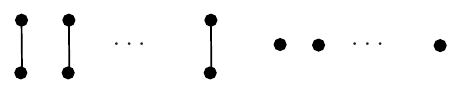
Figure 5: The maximal graph mK 2 ∪ ( n − 2 m ) K 1 in Theorem